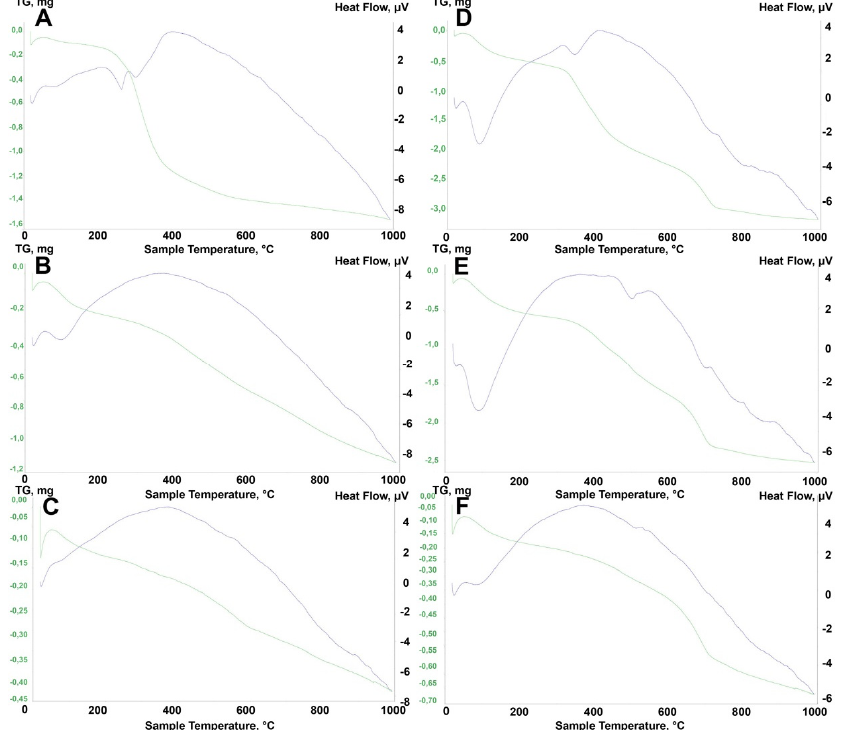
Figure 12. TGA curves of ( A ) ZrO2_250, ( B ) ZrO2_350, ( C ) ZrO2_450, ( D ) Al2O3_250, ( E ) Al2O3_350, and ( F )